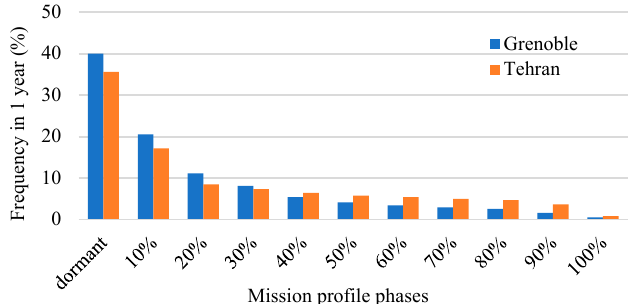
Figure 4. Mission profile expressed in 10 different phases. Percent length of each phase in Grenoble and Tehran.